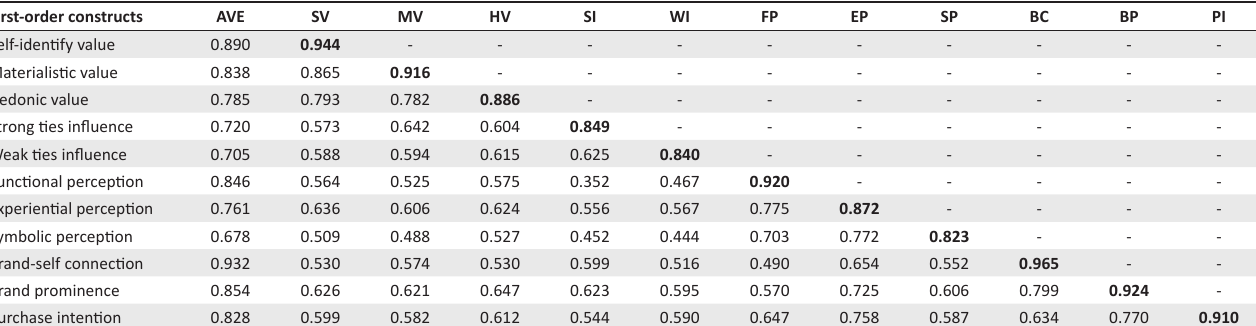
TABLE 3: Average variance extracted, square root of the average variance extracted (number in bold) and correlations among variables. First-order constructs